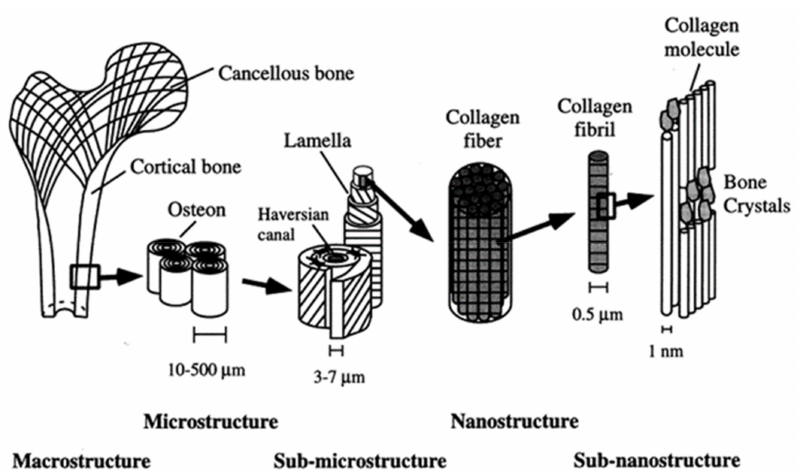
Figure 4. Hierarchical structural organisation of bone: (left to right) cortical and cancellous bone; osteons with Haversian systems; lamellae; collagen fibre assemblies of collagen fibrils; bone mineral crystals, collagen molecules and noncollagenous proteins. Reprinted from [96] with permission from